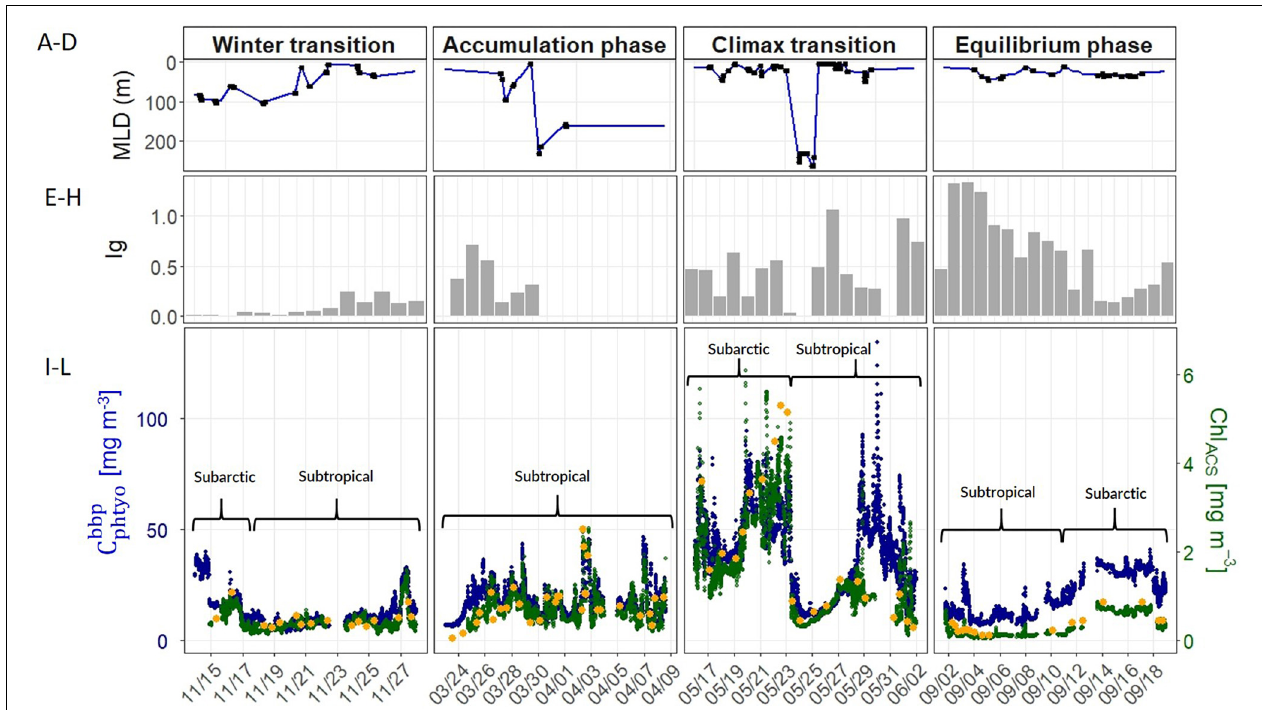
FIGURE 3 | (A–D) Mixed layer depth (MLD) measured during the four NAAMES field campaigns (labeled at top). Blue line indicates interpolated values between casts over the course of the science intensive transect, black circles indicate MLD values estimated from CTD profiles. (E–H) Median mixed layer light levels (I g , moles of photons m − 2 h − 1 ). (I–L) Optically-derived estimates of phytoplankton carbon ( C bbp phtyo , blue circles) and chlorophyll concentration (Chl ACS , green circles) binned to 1-minute resolution and plotted along the NAAMES science-intensive transect. Orange circles are HPLC-based estimates of surface chlorophyll concentration. Upper brackets distinguish subarctic and subtropical regions (see section “Spatio-Temporal Variability in Phytoplankton Carbon and Chlorophyll” for